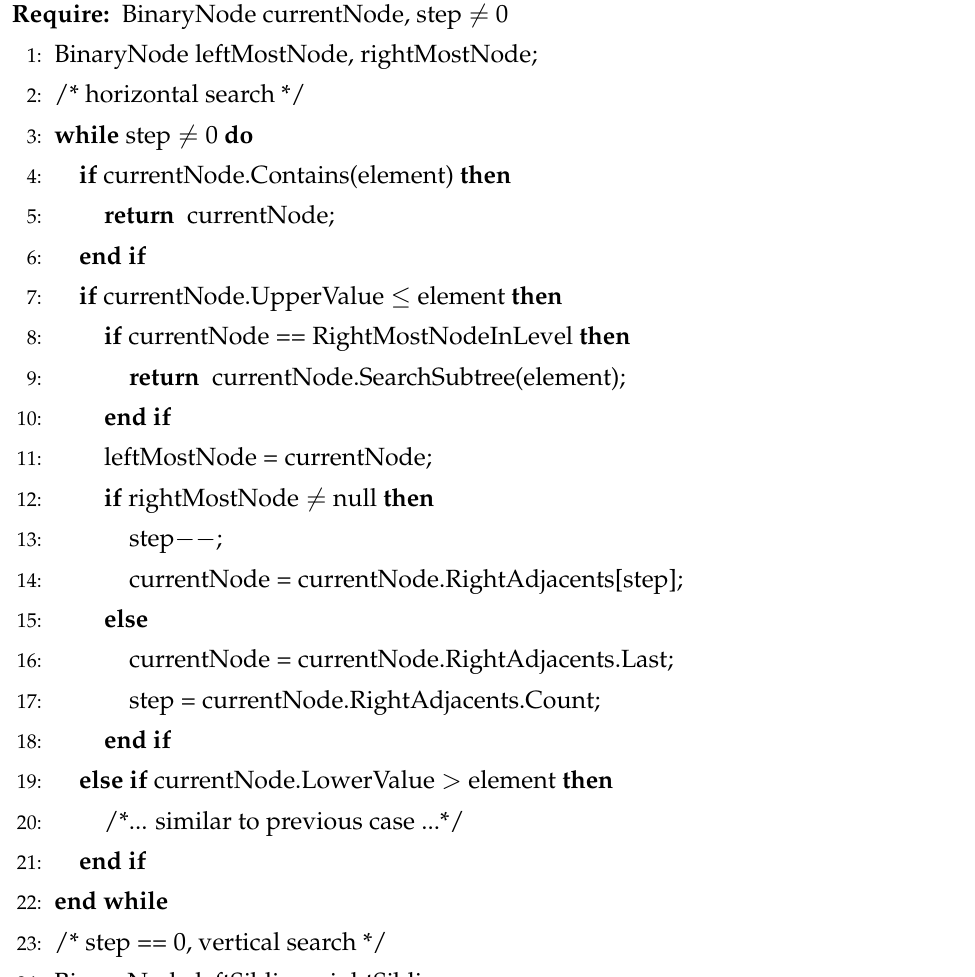
Algorithm 8 Search(integer